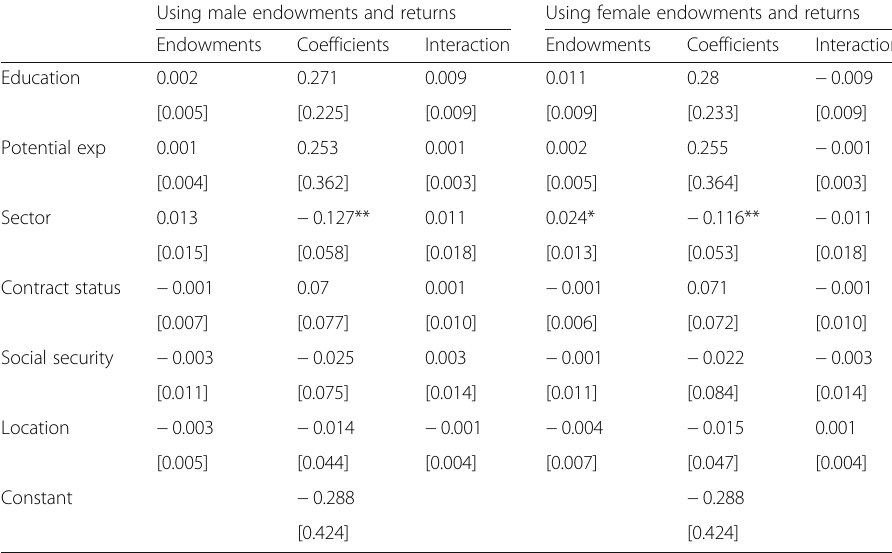
Table 18 Detailed Three-fold Income Decompositions: Tajikistan Using male endowments and returns Using female endowments and